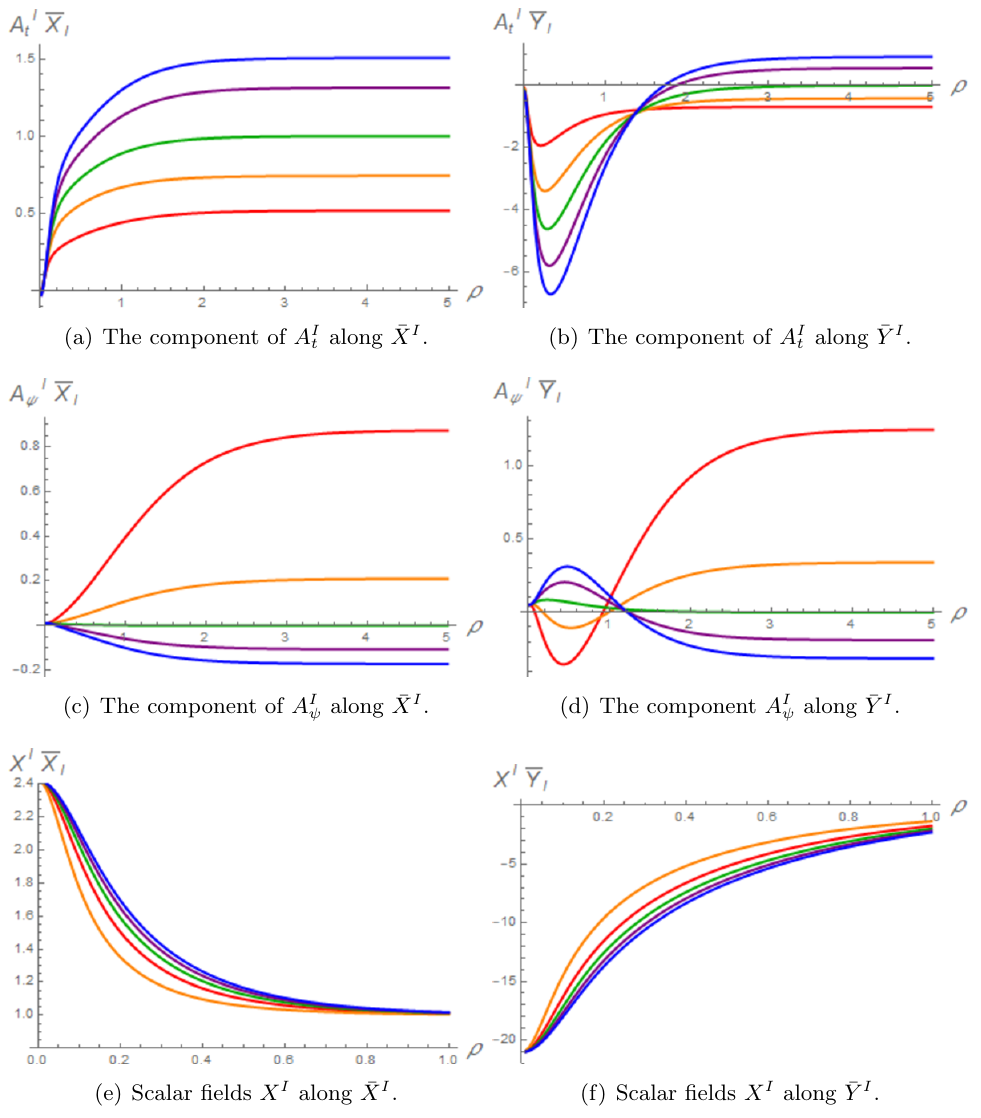
Figure 3 . Components of the gauge (cid:12)elds A I and of the scalar (cid:12)elds X I along (cid:22) X I and (cid:22) Y I